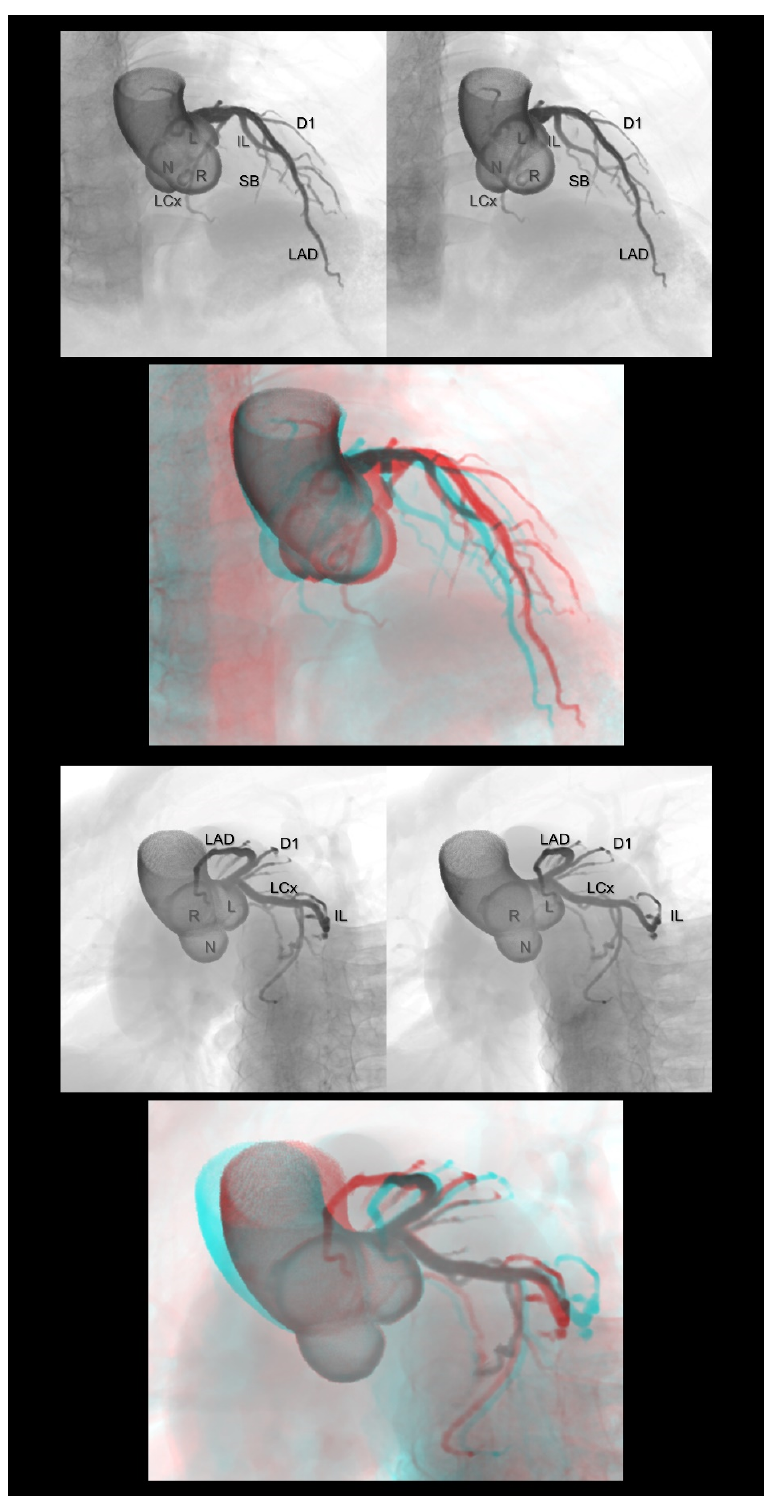
Figure 3. Right anterior oblique cranial view ( upper panels ) and left anterior oblique caudal view or spider view ( lower panels ) of the left coronary artery. The first and second panels are aligned for cross-eyed viewing. The third panel is the anaglyph. To see the anaglyph, anaglyphic glasses (red/cyan) are required. D1, first diagonal branch; IL, inferolateral branch; L, left coronary aortic sinus; LAD, left anterior descending artery; LCx, left circumflex artery; N, noncoronary aortic sinus; R, right coronary aortic sinus; SB, septal branch.